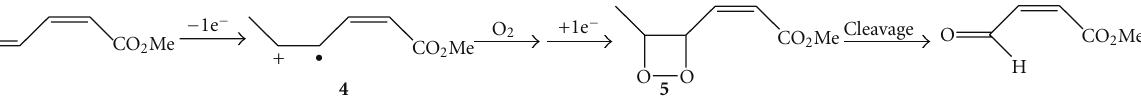
Scheme 3: Proposed mechanism for the aerobic alkene cleavage catalysed by